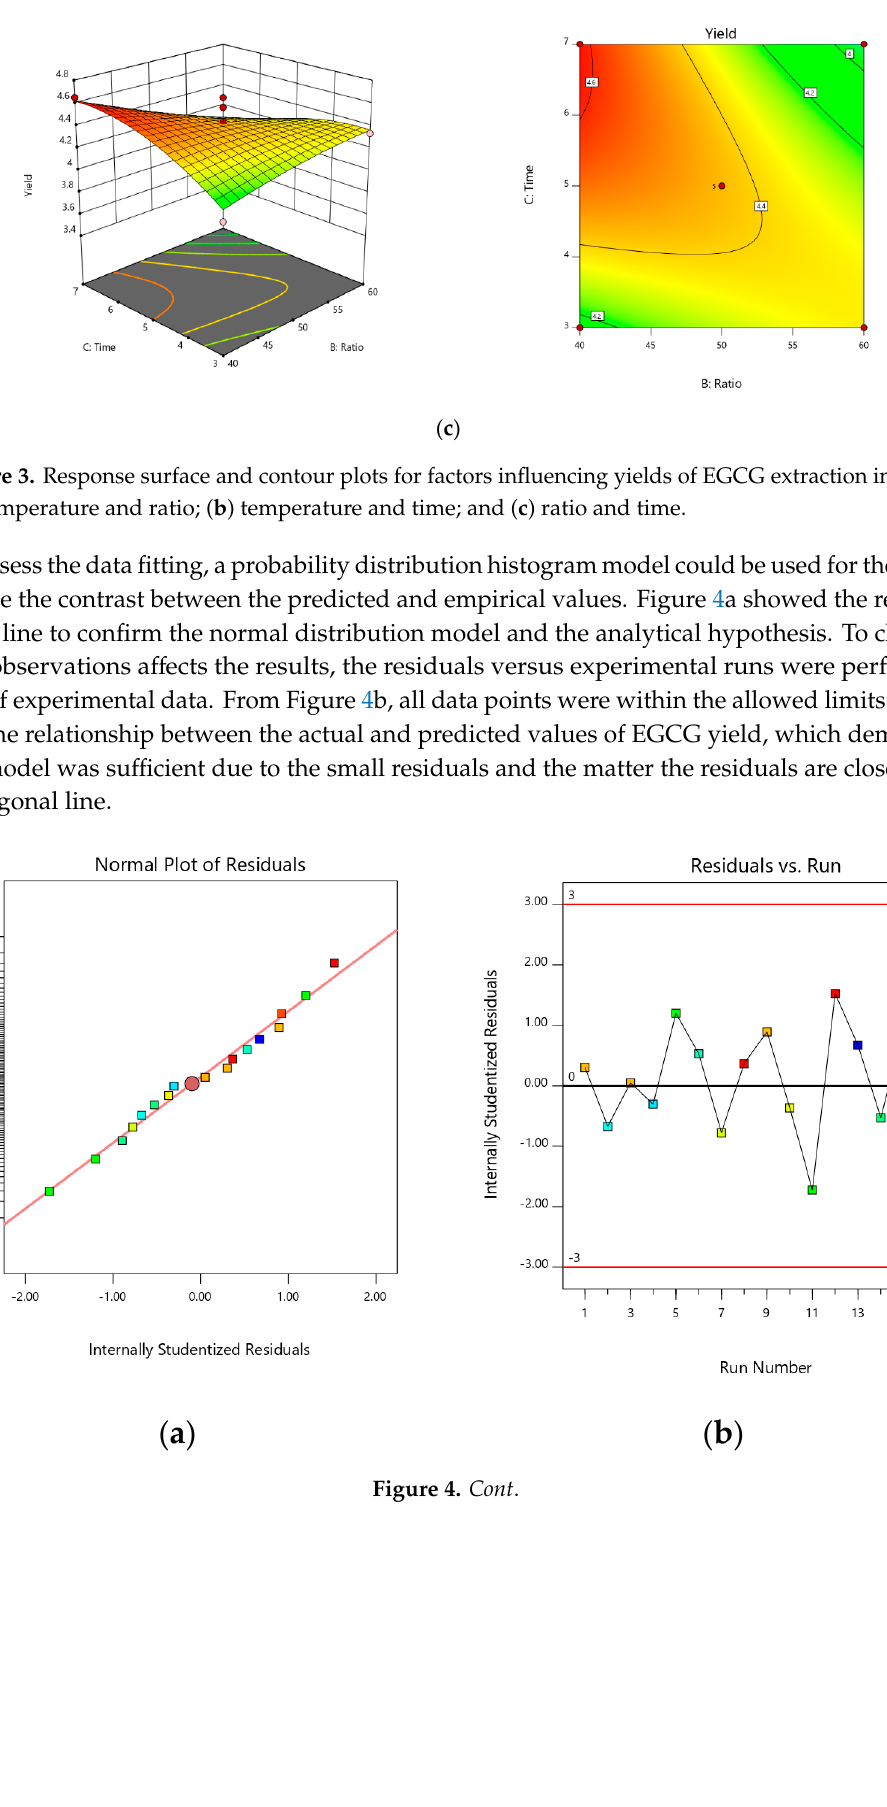
Figure 3. Response surface and contour plots for factors influencing yields of EGCG extraction include ( a ) temperature and ratio; ( b ) temperature and time; and ( c ) ratio and time.